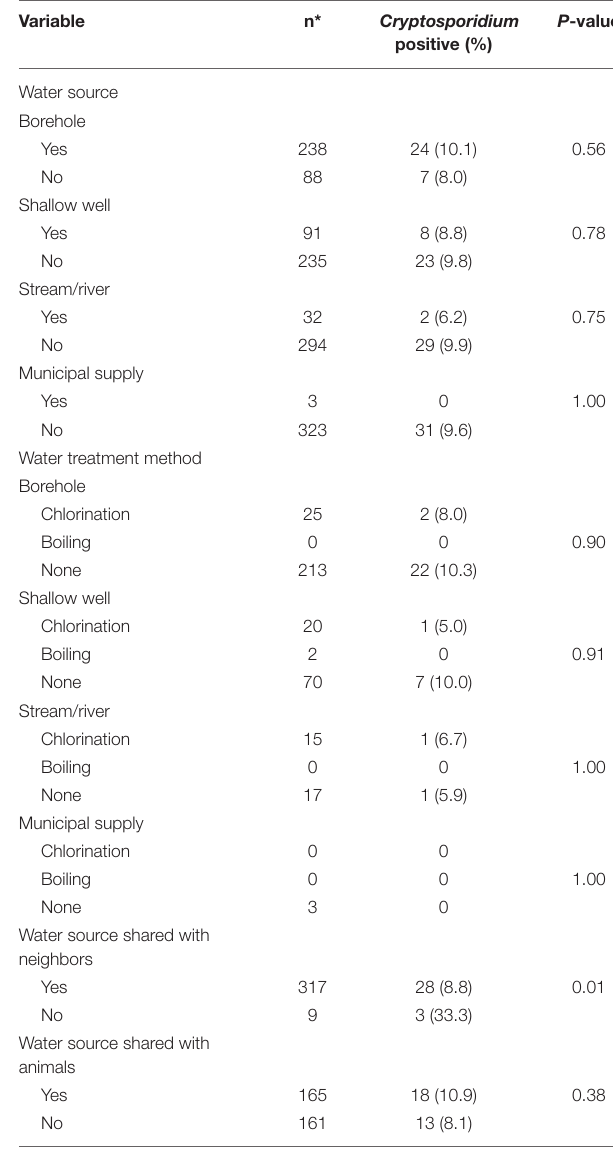
Table 2 summarizes associations of Cryptosporidium infection and environmental characteristics considered among adult HIV positive patients. Household water sources, treatment of water before consumption, treatment method and sharing water source with animals were not significantly associated Cryptosporidium infection. However, sharing water source with their neighbors was significantly associated with infection ( p =